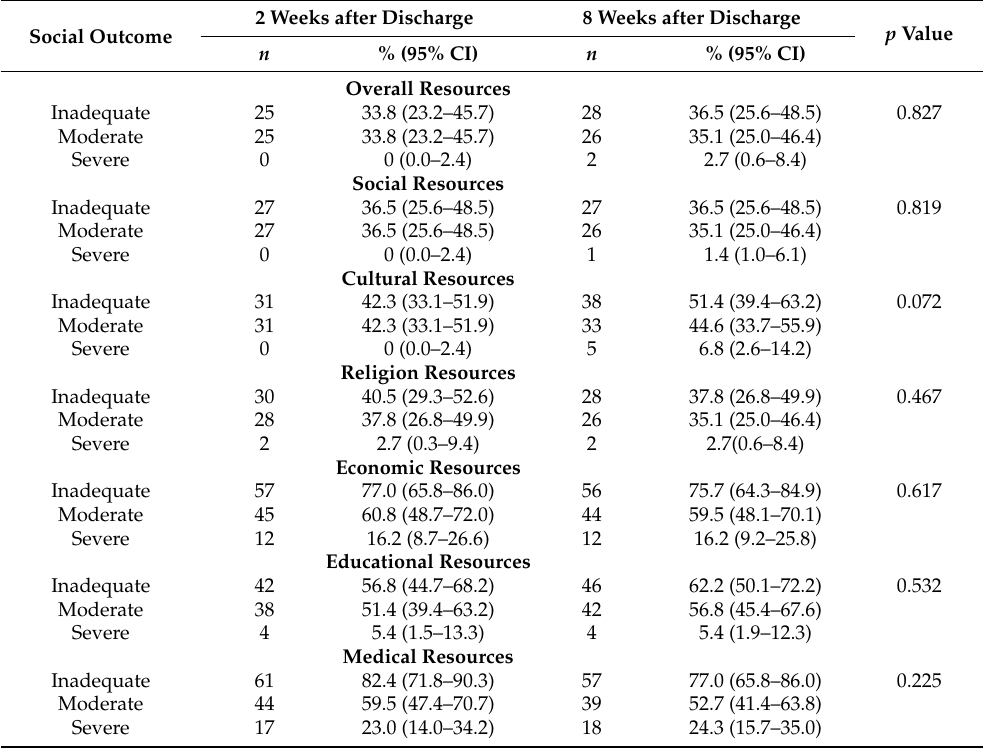
Table 6. The proportion of patients’ family members with perceived inadequate family resources at 2 and 8 weeks after discharge of their relatives with COVID-19 infection from the study sites ( n = 74). 2 Weeks after Social Outcome